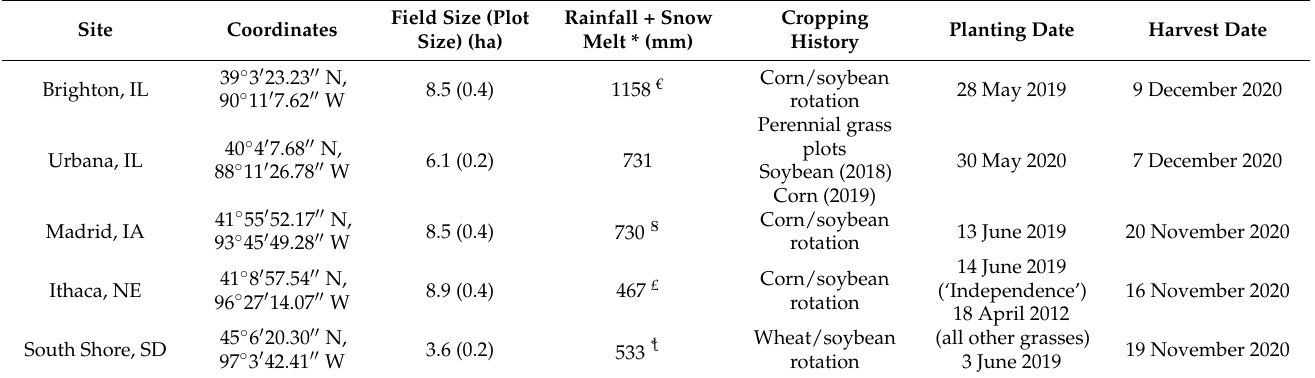
Table 1. Field site characteristics and crop management.